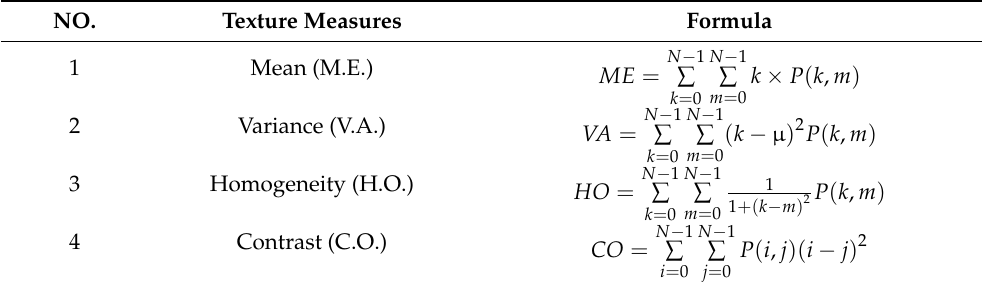
Table 4. The grey level co-occurrence matrix (GLCM) texture features and their